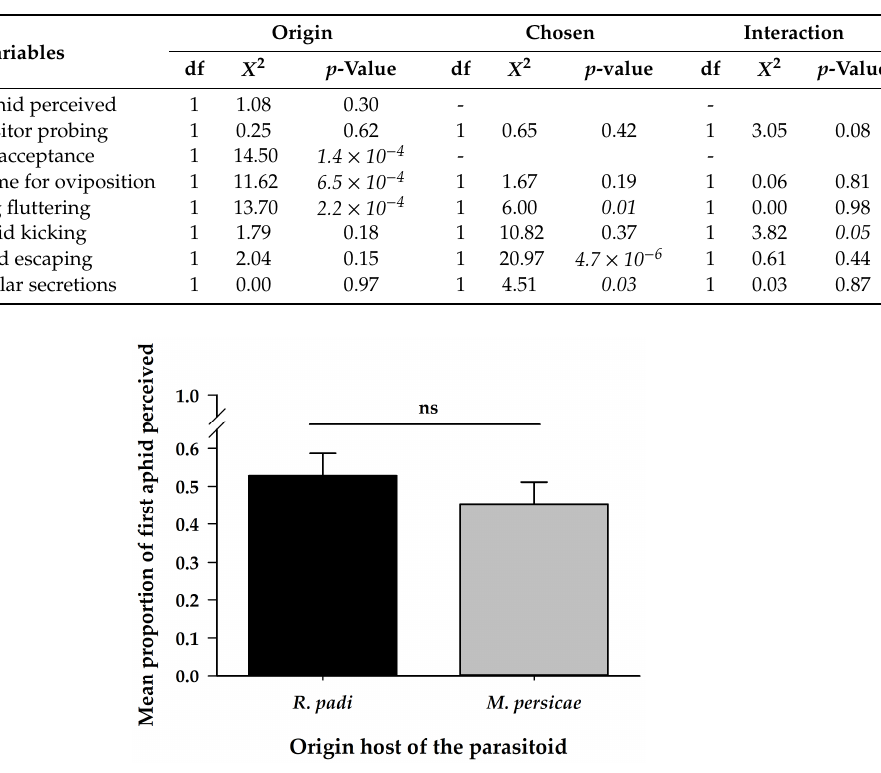
Table 1. Choice experiment. Generalized estimating equations (GEE) showing the effect of the origin host and chosen aphid and the interaction between these two factors on the different behaviours of A. platensis and of the aphids R. Padi and M. Persicae . For each level, the degrees of freedom (df), the Chi-square statistical test and the p -value are represented.